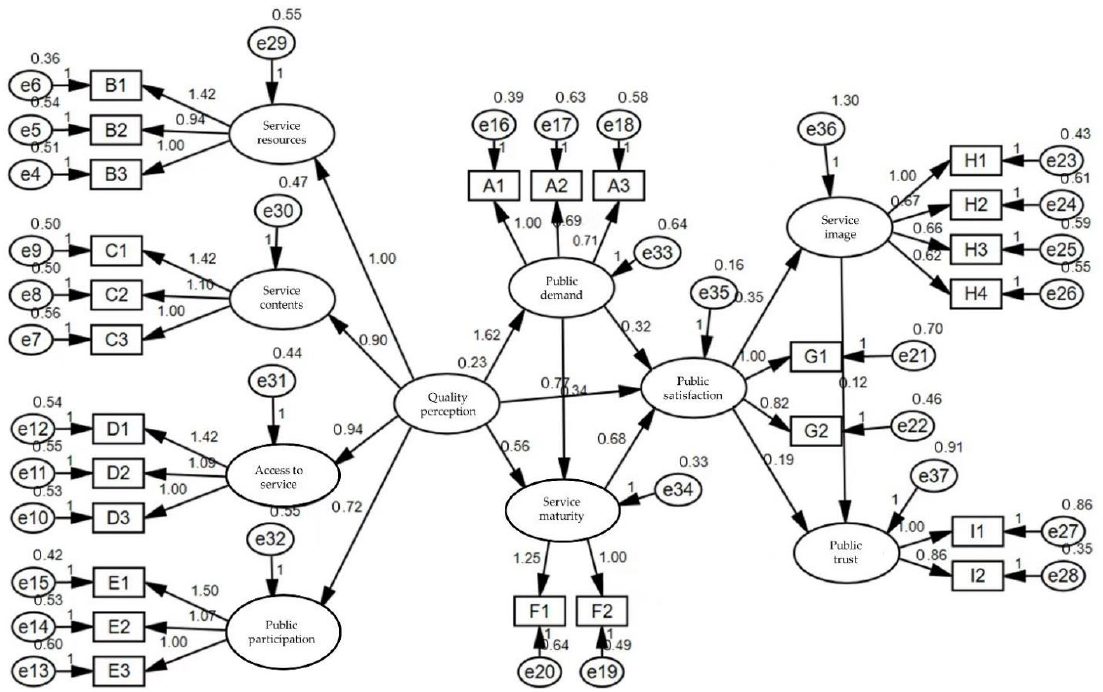
Figure 3. The public satisfaction model in a highly educated community.